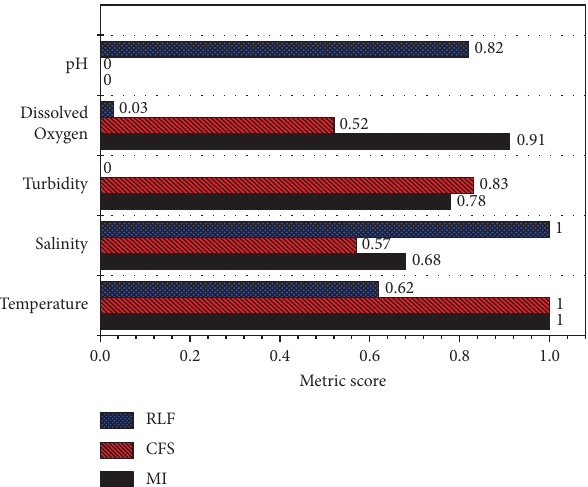
Figure 6: Infuence of water quality variables on harvest outcome, considering yield as the main